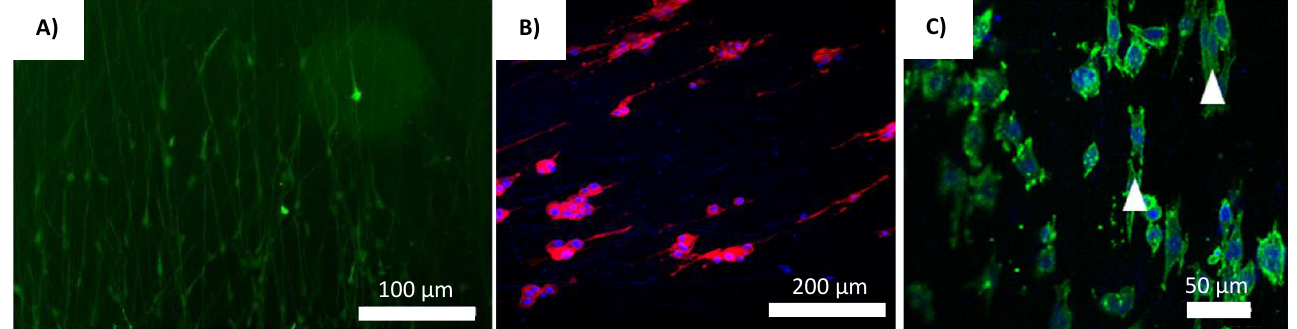
Figure 4. Cells cultured on different electro-spun scaffolds. ( A ) Primarily the GFAP+ cells migrated along the fibers in straight lines [64]. Reprinted with permission copyright © 2017 by authors and Scientific Research Publishing Inc. ( B ) PC12 cells on LLA-GO nanofibrous scaffolds coated with 1.0 mg/mL GO solution [65]. Reprinted with permission copyright © 2016 Acta Materialia Inc. Elsevier Ltd. ( C ) DPSCs on PLO-coated aligned PCU fibrous scaffolds [66]. Reprinted with permission cop-